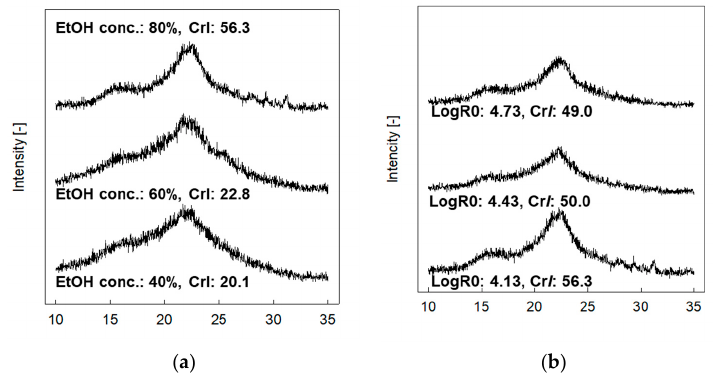
Figure 4. Diffraction patterns and CrI s (crystallinity indices) of organosolv-treated residual solids based on ( a ) ethanol concentration and ( b ) reaction severity (log R 0 : 4.13, 4.43, and 4.73). Reactions: ( a ) 190 °C; 30 min; 40%, 60%, and 80% ethanol concentrations; solid:liquid = 1:10; 0.25 wt.% sulfu- ric acid concentration. ( b ) 190 °C; 30 min, 60 min, and 120 min; an 80% ethanol concentration; solid:liquid = 1:10; 0.25 wt.% sulfuric acid concentration.